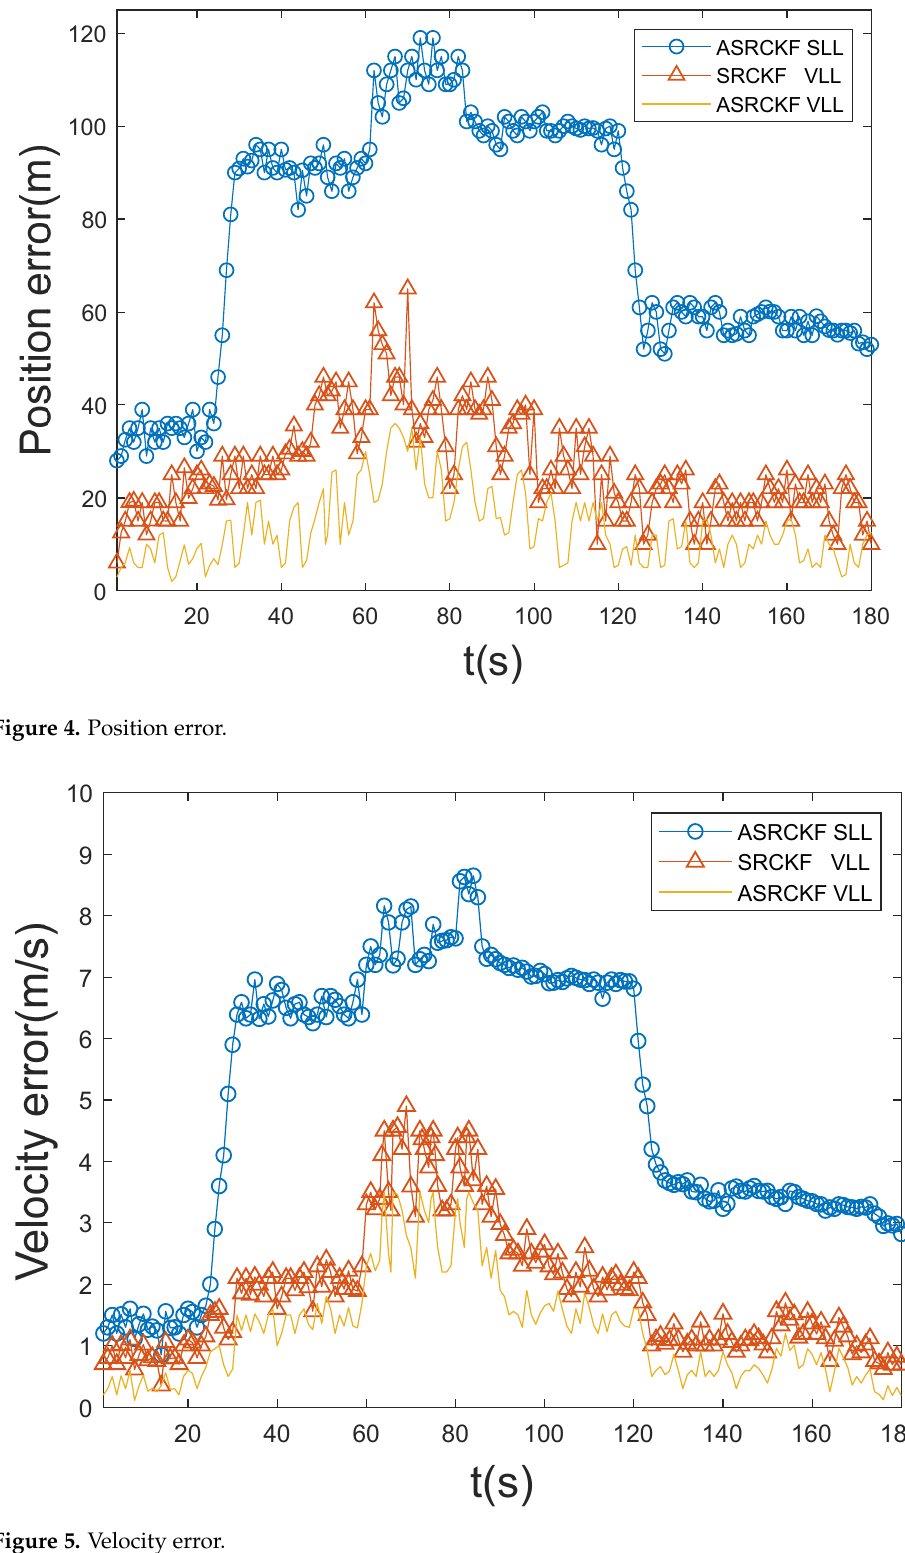
Figure 5. Velocity error.